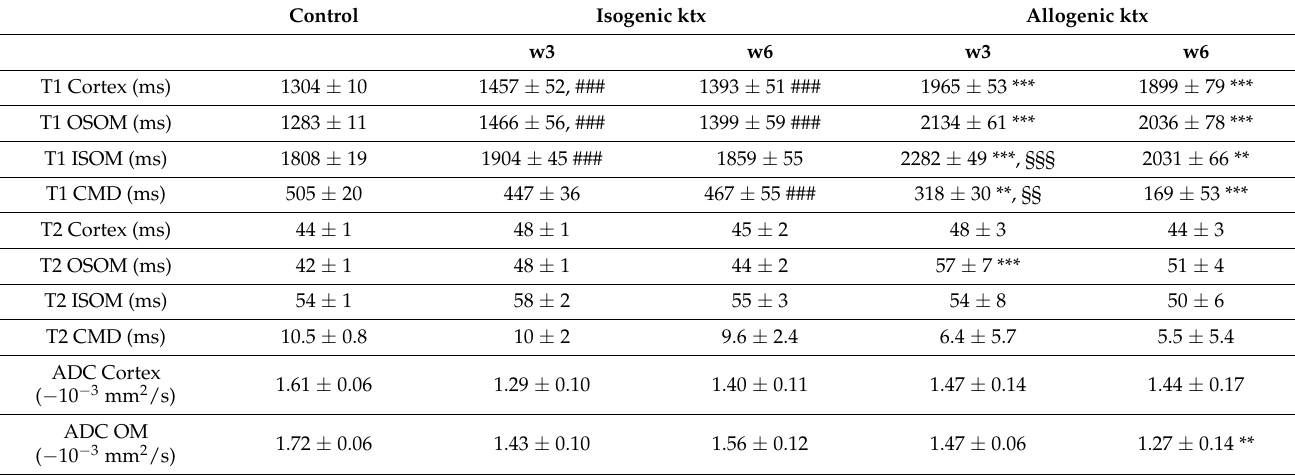
Table 1. Functional MRI parameters after isogenic and allogenic kidney transplantation and in control